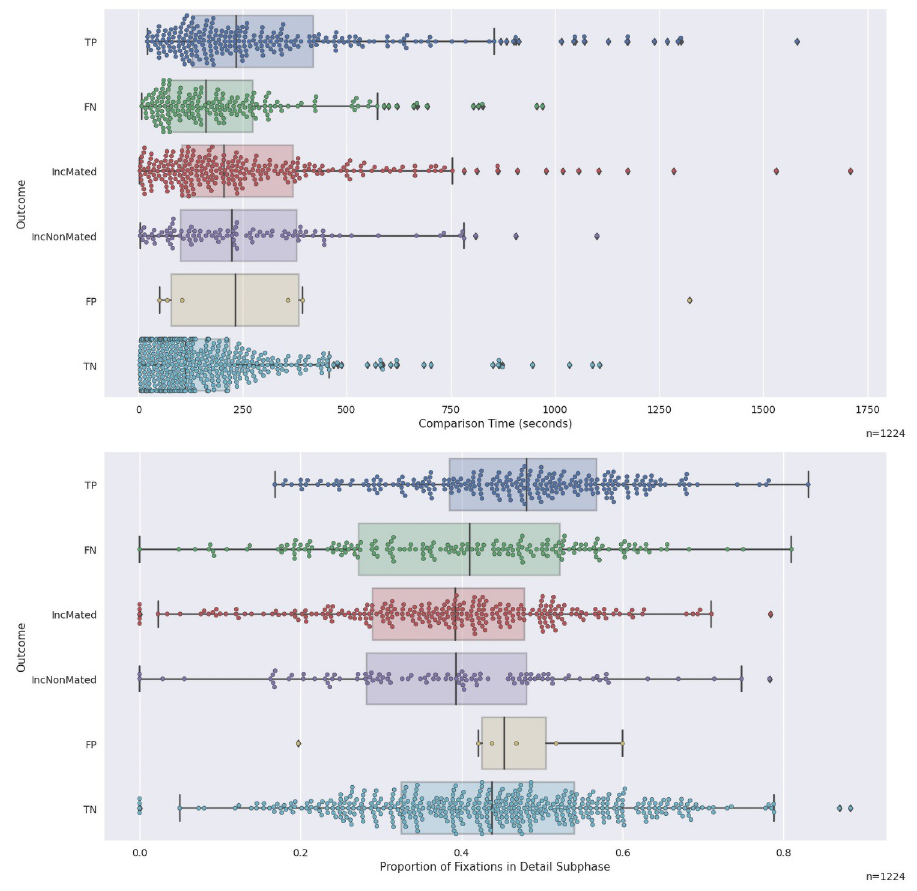
Fig 2. Distributions of comparison times and detail fixations with respect to outcome. Top panel: distributions of comparison times for the six outcomes. Bottom panel: distributions of proportion of fixations in the detail subphase. For all box-and-whiskers plots, the vertical line is the median, the box represents the interquartile range (25 th through 75 th percentiles), and the whiskers are 1.5 times the inter-quartile range when there are outliers outside this range (singleton diamond symbols) and express the full range of data where there are no outliers. Colored dots are data from individual trials overlaid on the boxplots. Note that there are 1444 mated trials, but only 1224 trials contribute to most of our analyses due to 220 No Value trials. For all figures, the number of trials contributing to the data is presented in the lower-right corner.